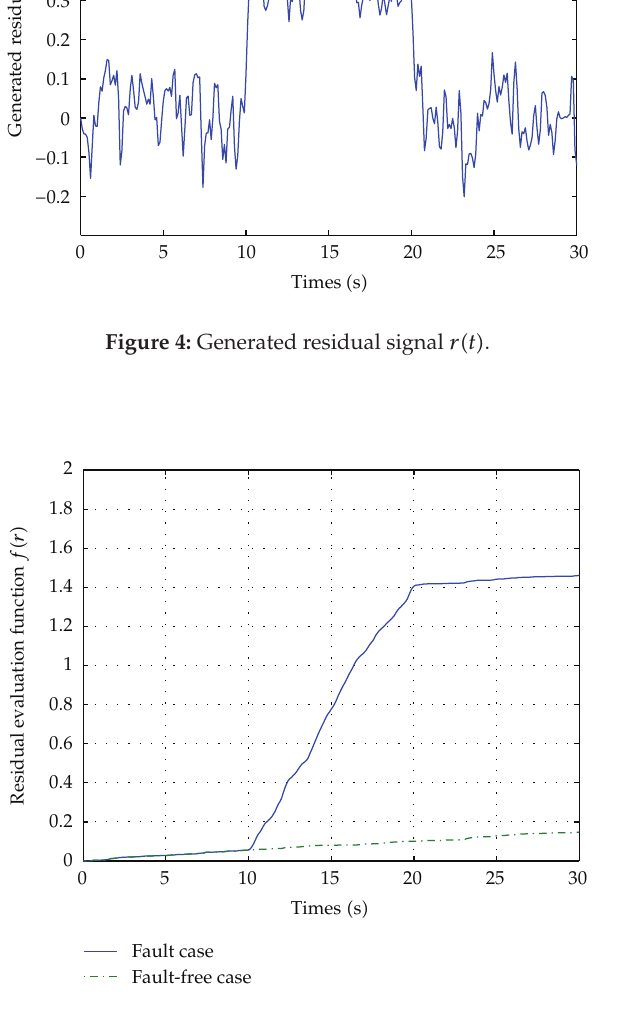
Figure 5: Evolution of residual evaluation function f (cid:6) r (cid:7)